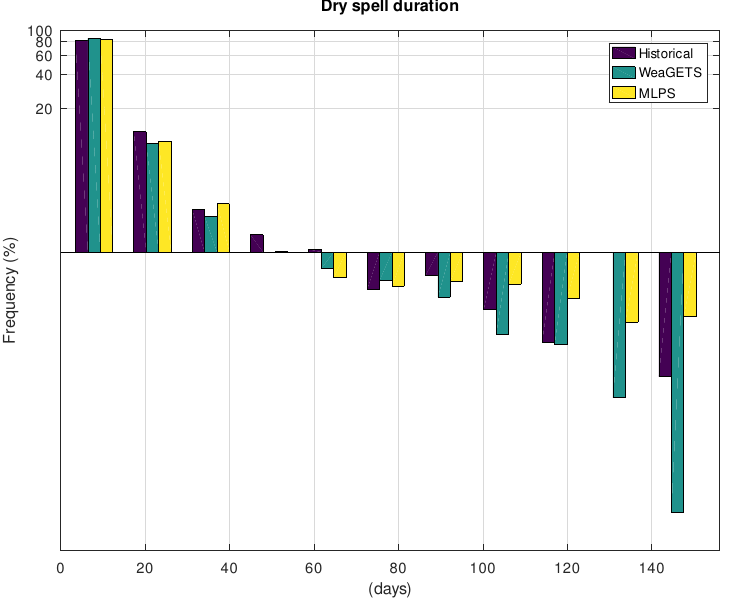
Figure 14. Histogram of the duration of dry spells of daily synthetic time series (WeaGETS and MLPS) and historical values of the Gibraltar weather station. Figure 15 displays the climacogram of the Gibraltar time series. MLPS fits very well with the marks of the historical time series, except at greater